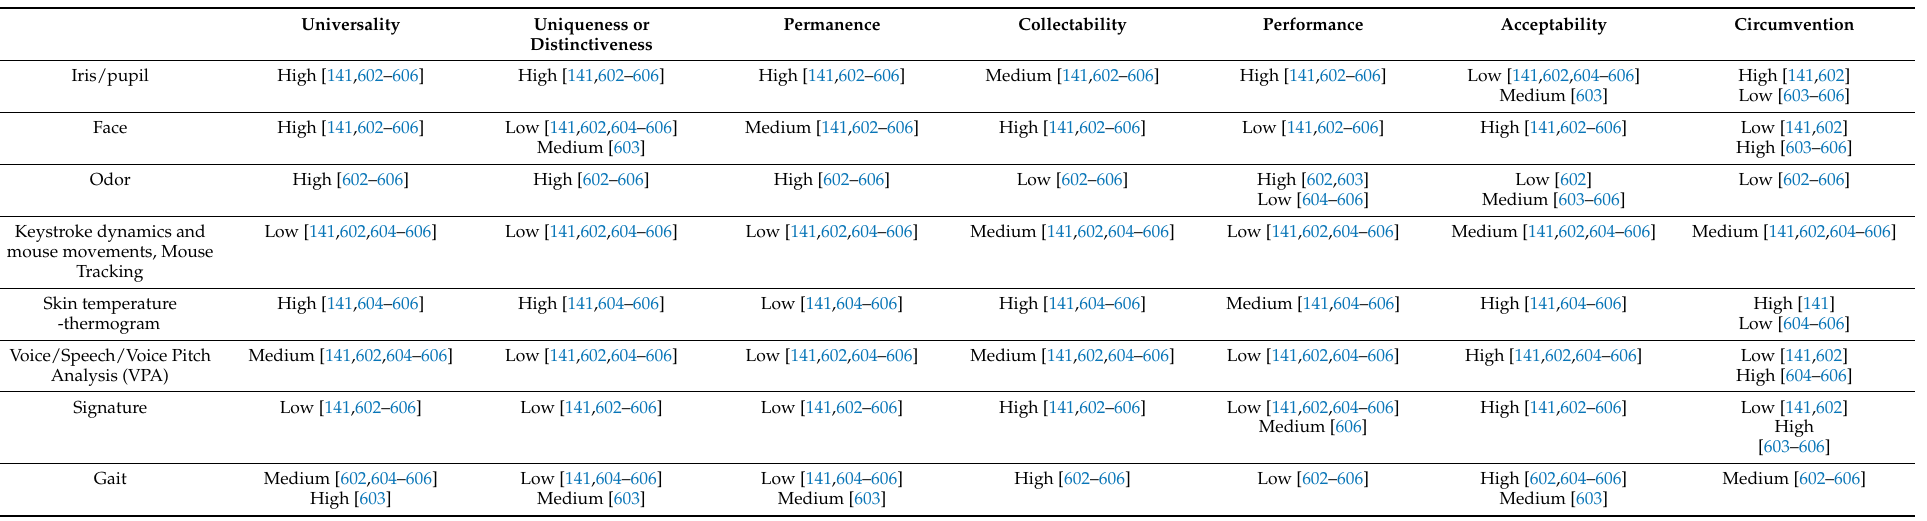
Table 10. Comparison of biometric technologies by seven characteristics